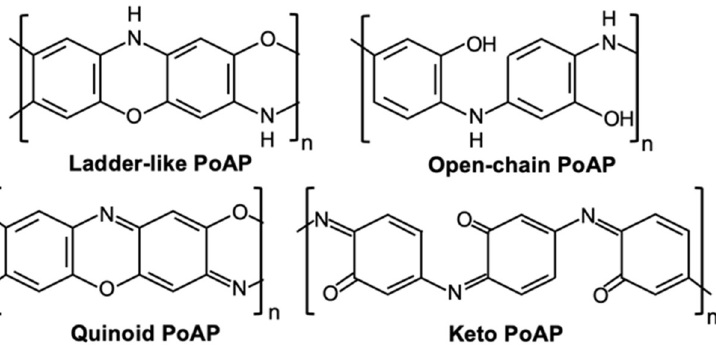
Figure 1. Non-oxidated (ladder-like and open-chain) and oxidated (quinoid and keto) structures of PoAP.